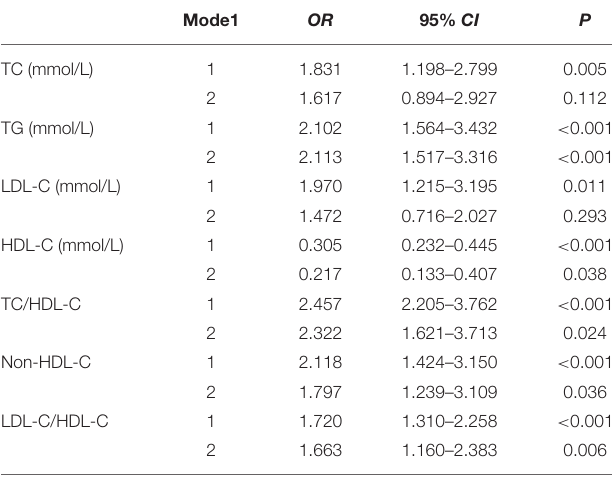
TABLE 4 | Logistic regression analysis of the association between the severity of PAP and lipid ratios. Mode1 OR